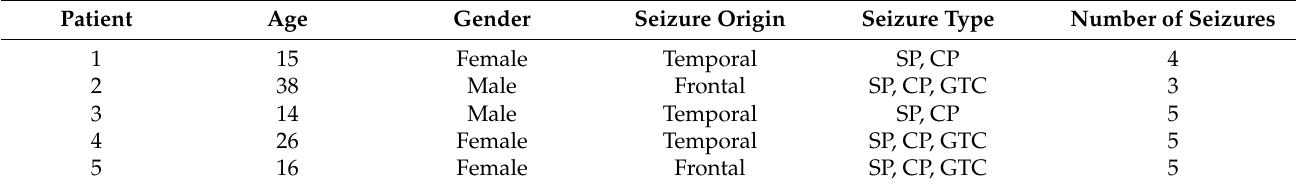
Table 3. More details about the Fribourg